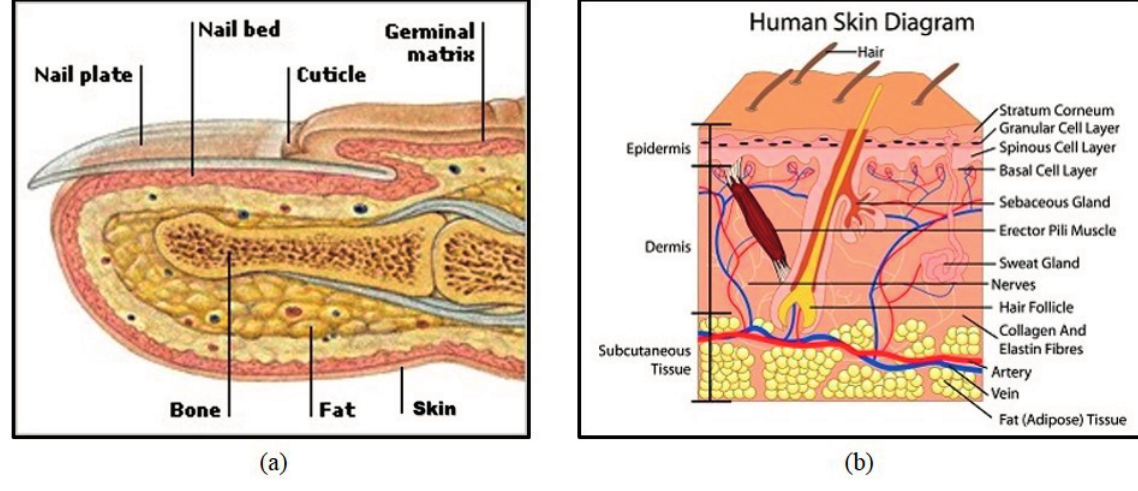
Figure 1. Human finger structure: ( a ) cross-section [23] and ( b ) skin diagram